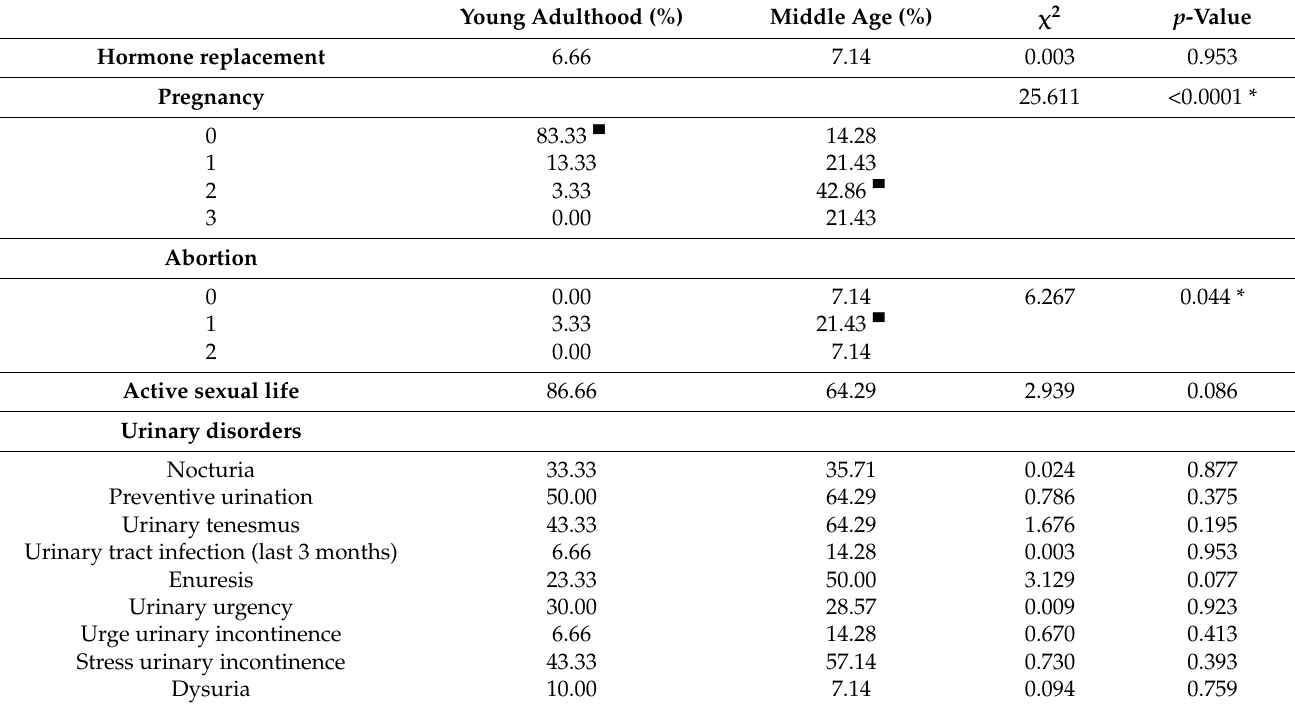
Table 2. Clinical variables in the groups: young adulthood ( n = 30) and middle age ( n = 14).